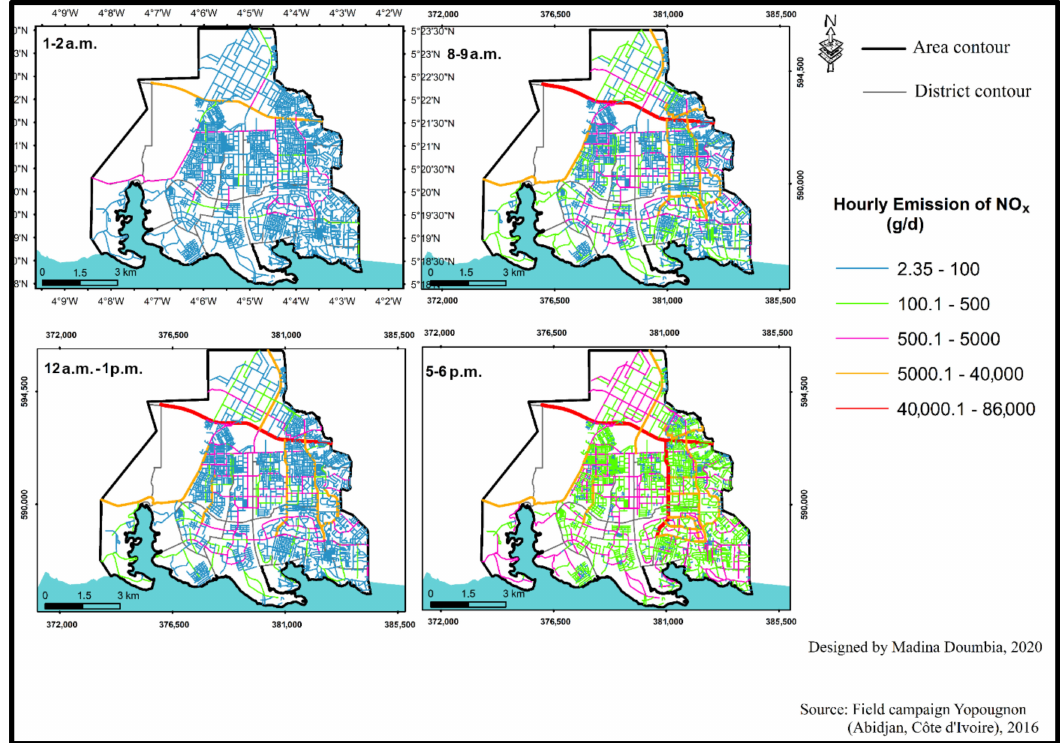
Figure 7. Spatial distribution of pollutant emissions of NO x at different